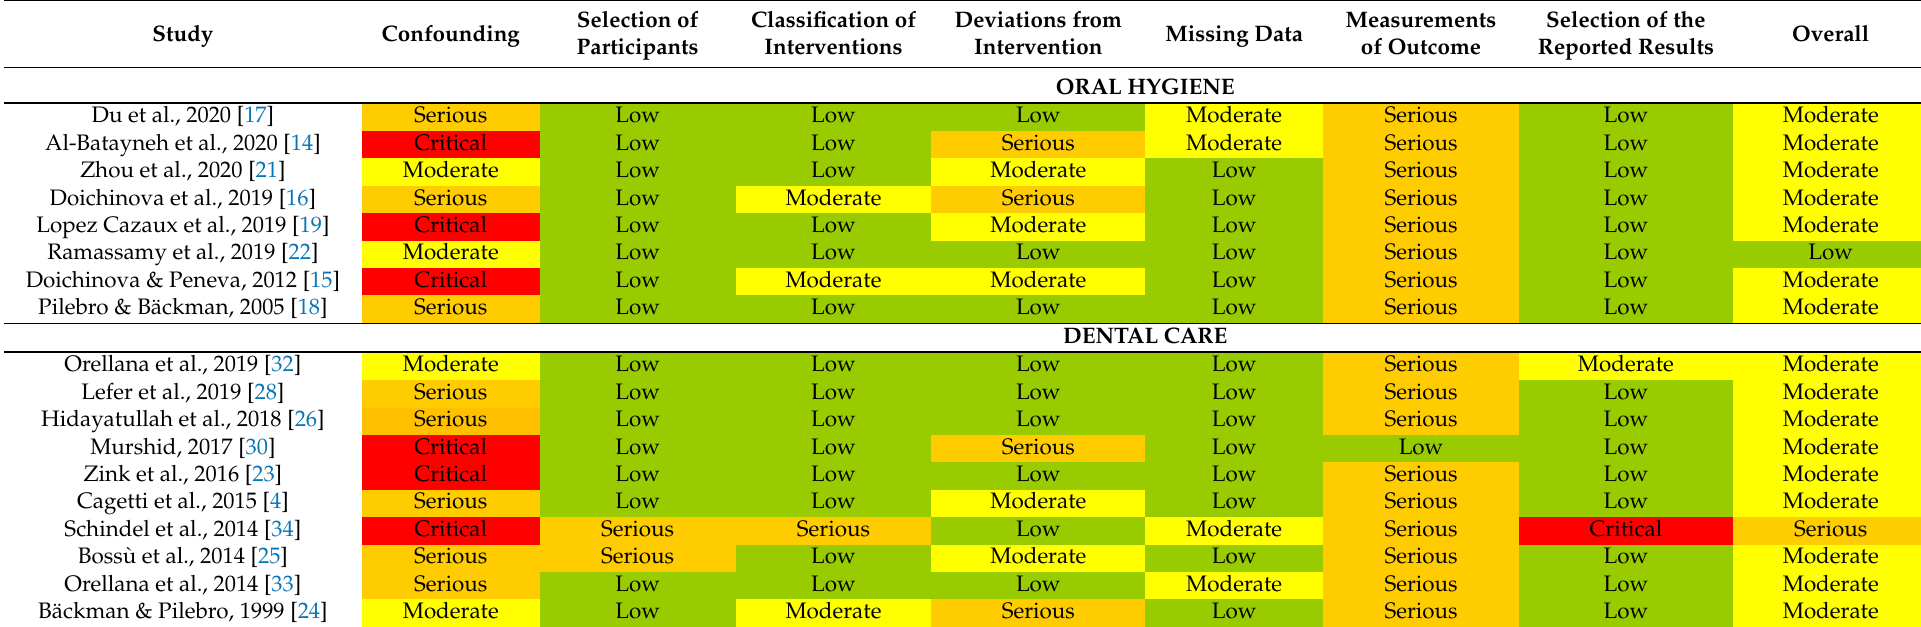
Table 4. Risk of bias assessment of non-randomized studies of intervention (NRSI) using the ROBINS-I